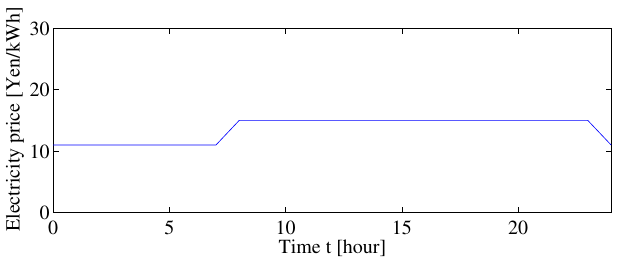
Figure 8. Predicted load demand.